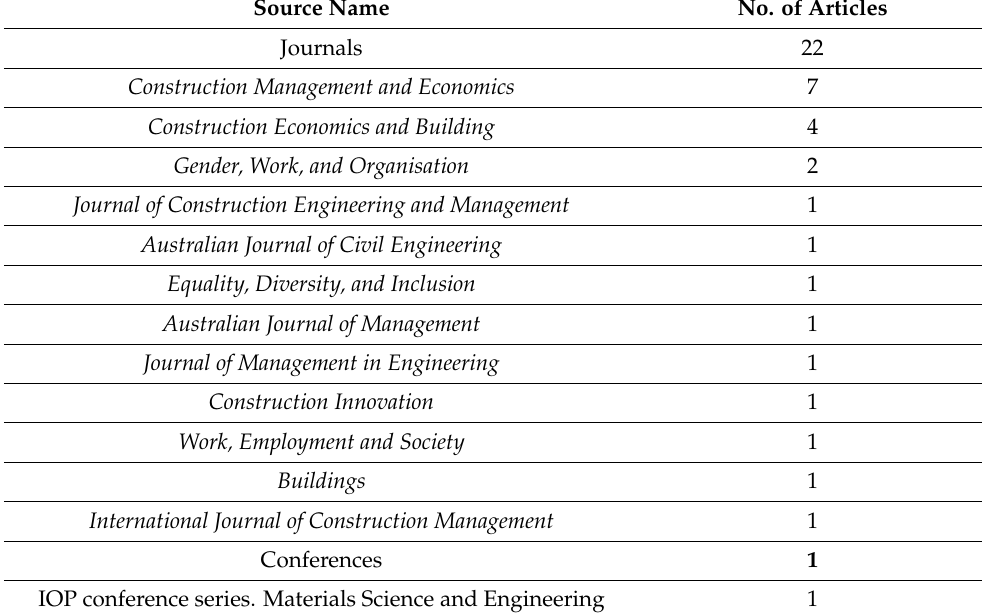
Table 2. The number of articles published in journals and conference